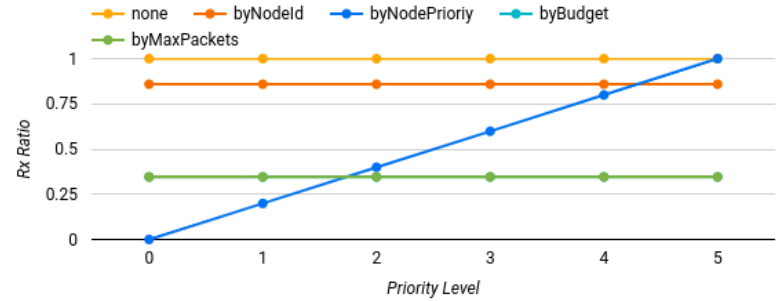
Figure 9. Results when varying the priority